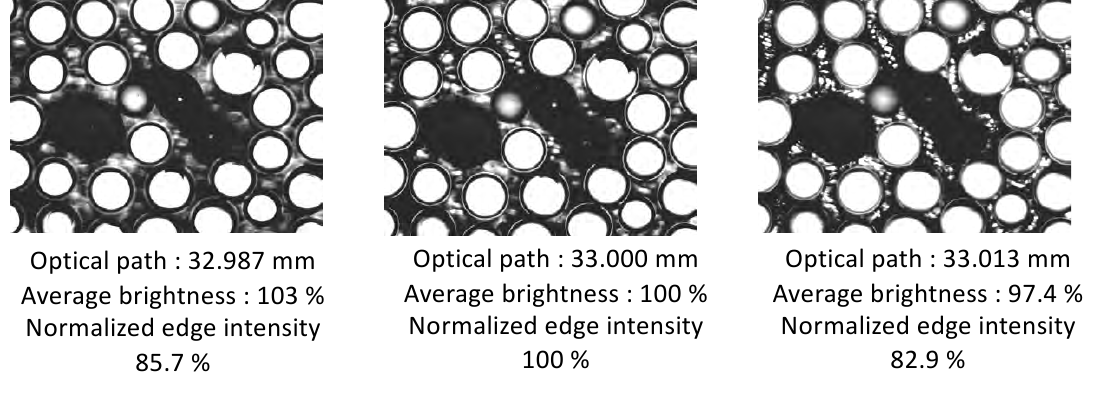
Figure 10. Images with edge intensities is within the threshold value.